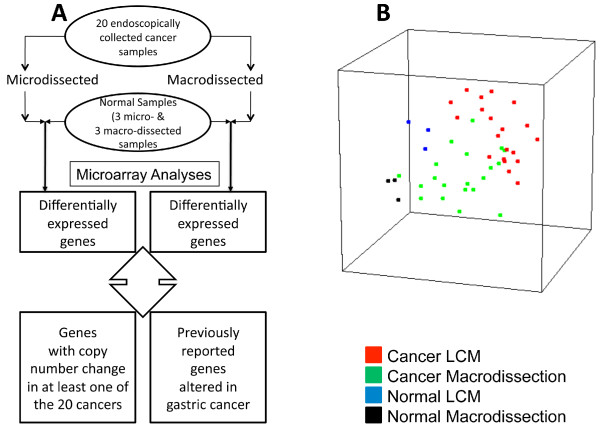
(A) Study scheme of sample collection and microarray processing (B) Principal component analysis of gene expression profiles of micro- and macro-dissected tumor samples from 20 gastric cancer patients and 6 normal samples from healthy volunteers.